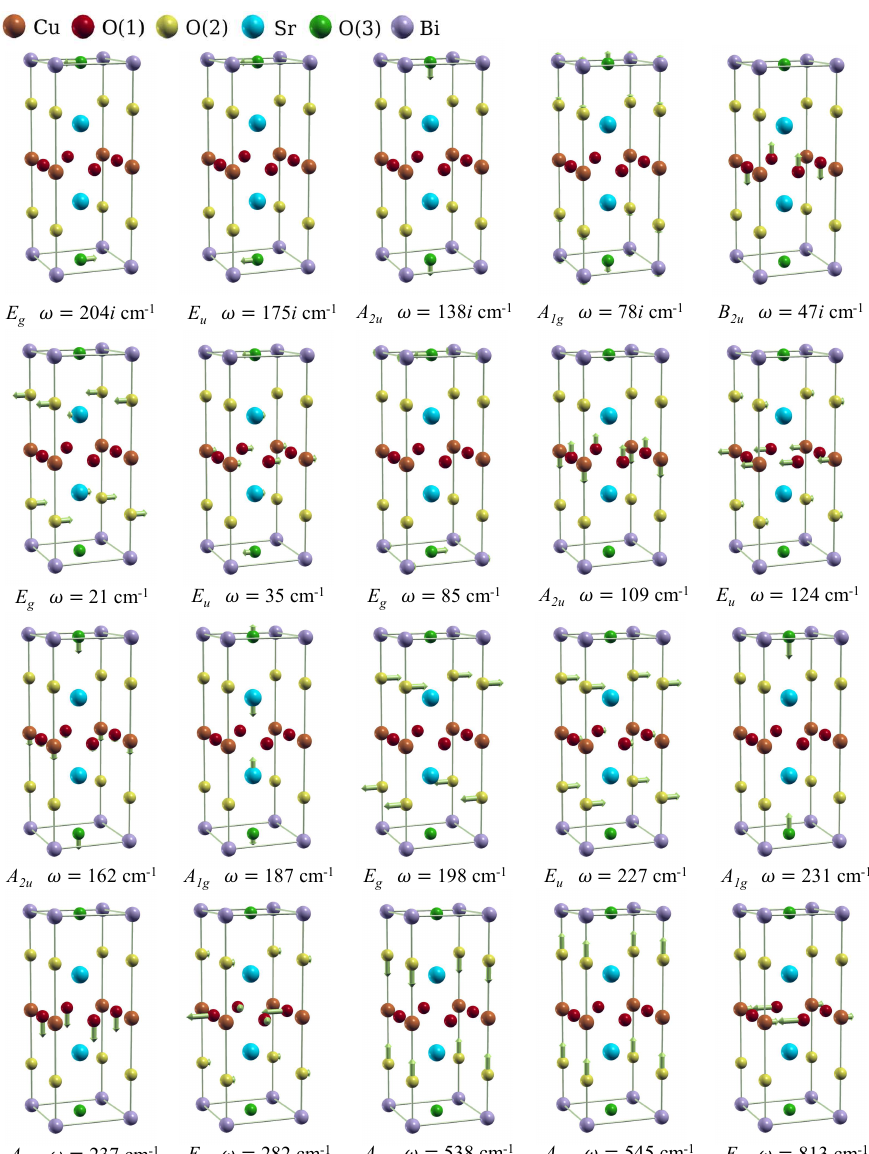
Figure A4: All optical Bi2201 modes at the Γ